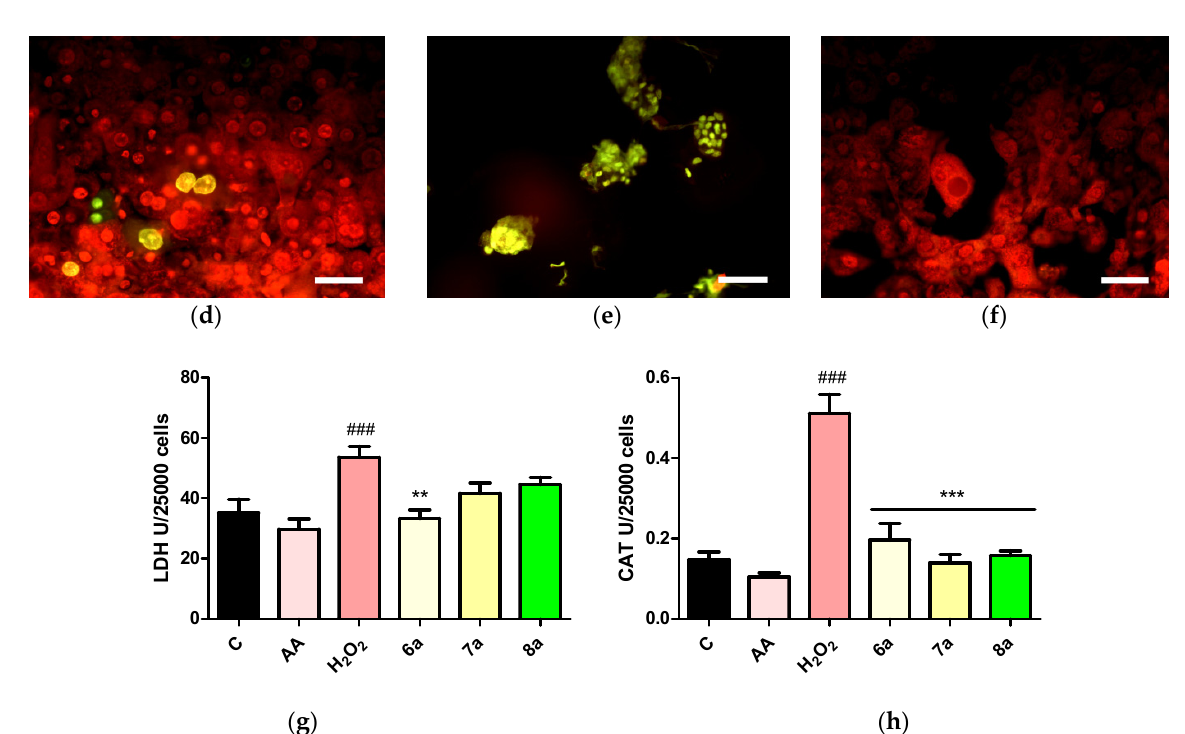
Figure 6. Acridine-orange staining ( a – f ) and enzymes assay (g-h) of the control and treated HaCaT cells: ( a ) control; ( b ) ascorbic acid (AA); ( c ) hydrogen peroxide (H 2 O 2 ); ( d ) 6a ; ( e ) 8a ; ( f ) 7a . Scale bar = 20 µm, × 400. Enzymes assays are presented for lactate dehydrogenase (LDH) ( g ) and catalase (CAT) ( h ) in U/no. of the cells. p < 0.05 was considered statistically significant. The significance was marked with ** for p < 0.01, *** for p < 0.001 (compared to H 2 O 2 effects) and ### for p < 0.001 for the comparison with the AA effects.